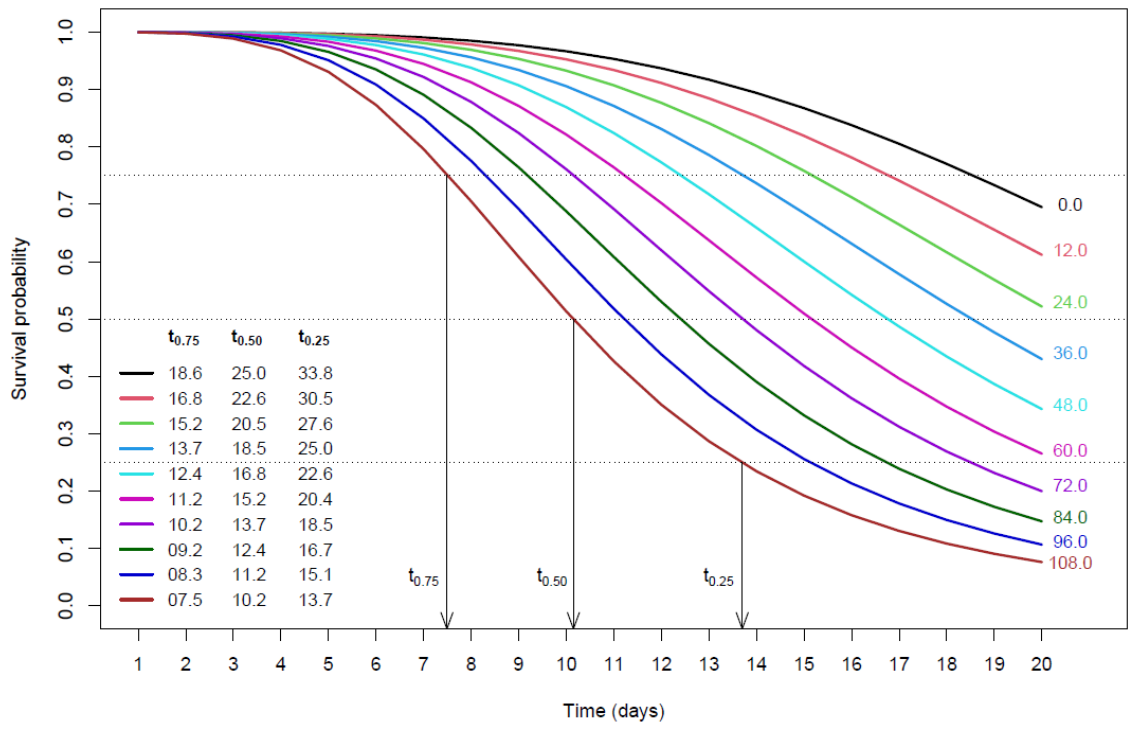
Figure 2. Survival curves estimated by Log-logistic model for Chrysoperla externa exposed to different doses (mg a.i. L − 1 ) in Azamax ® . The times for 75%, 50%, and 25% of the individuals to be alive are also presented.